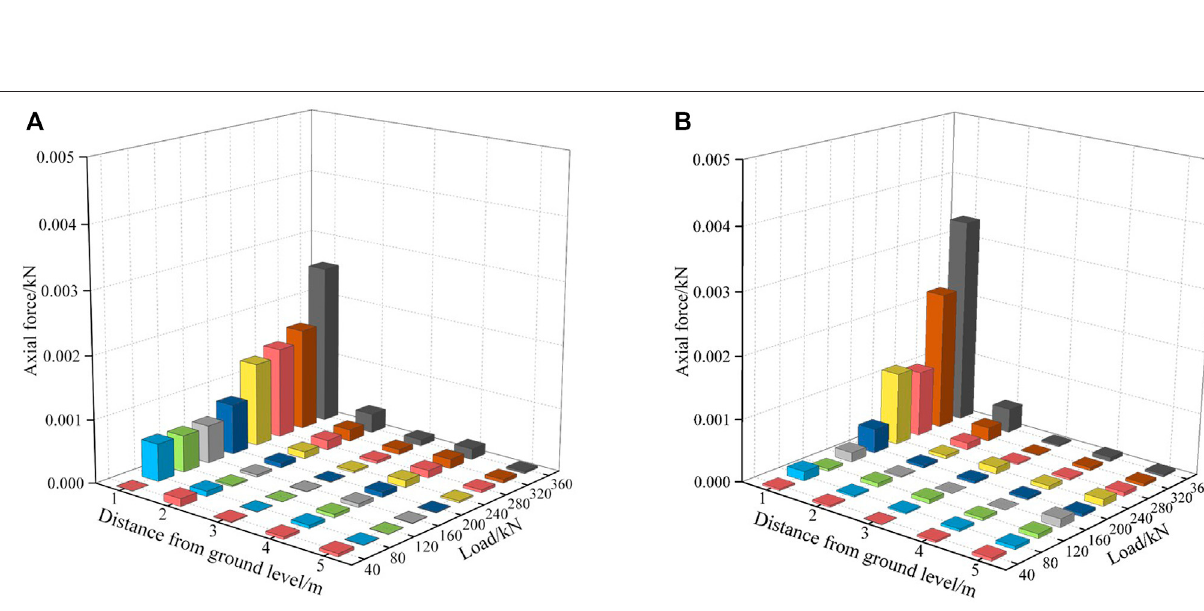
Frontiers in Materials |